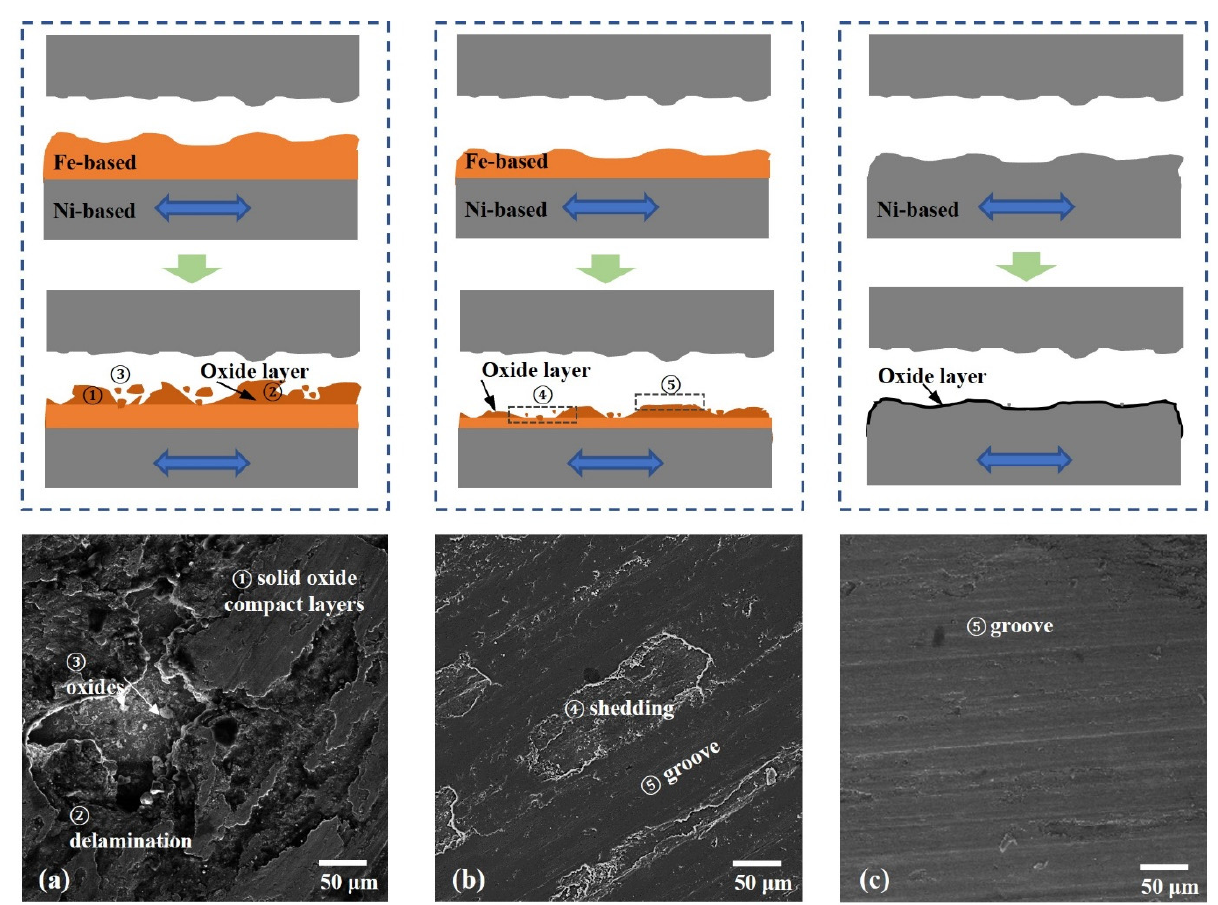
Figure 12. Wear mechanisms illustration. ( a ) series 2 ; ( b ) series 0 ; ( c ) series -2.